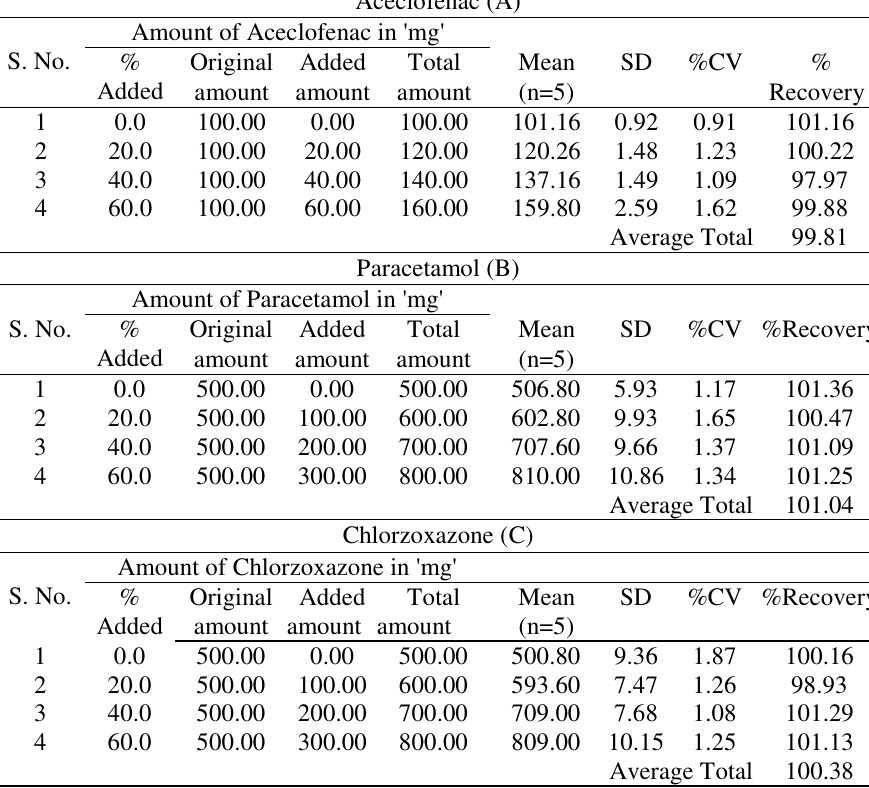
Table 2. Results of recovery experiments (A, B,